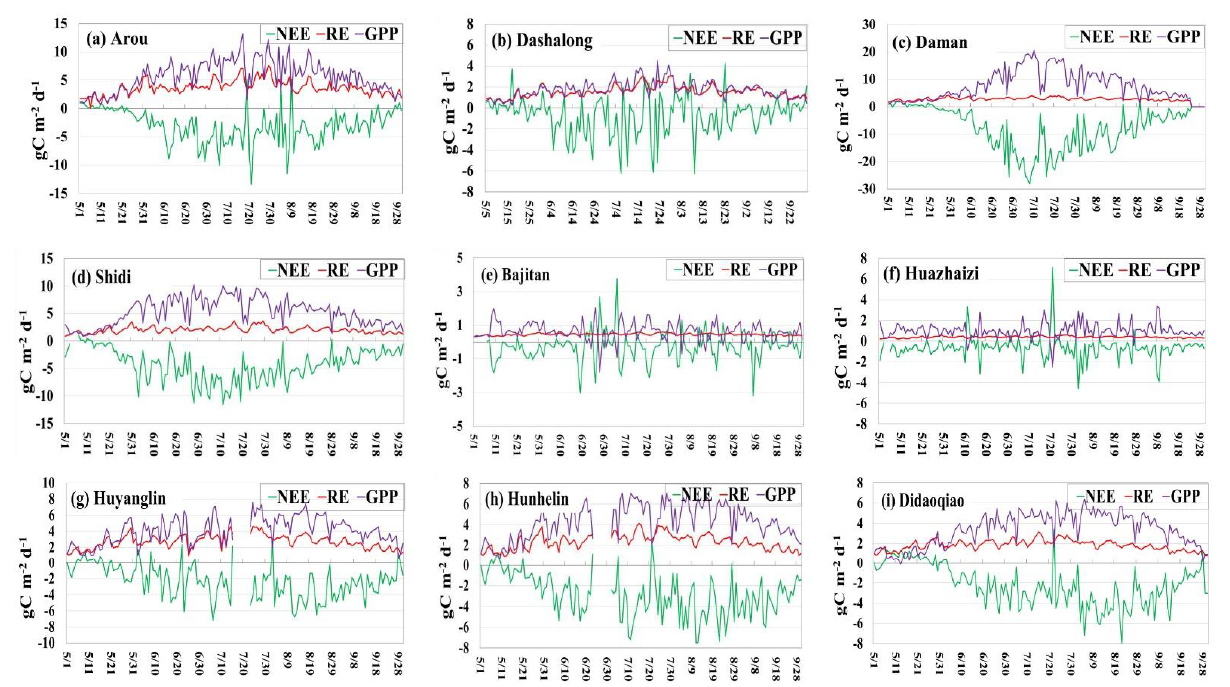
Figure 3. Seasonal variation in GPP, respiration of ecosystem (RE) and net ecosystem carbon dioxide exchange (NEE) in the growing season.